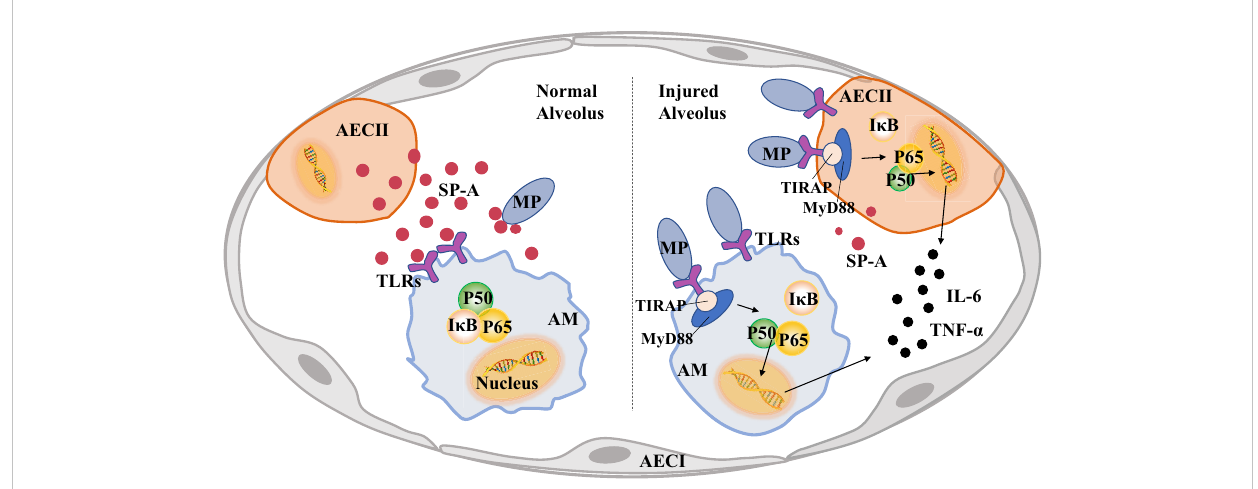
FIGURE 4 Pulmonary surfactant protein A (SP-A) links alveolar macrophages (AMs) and alveolar epithelial cells (AECs) to reduce lung injury caused by Mycoplasma pneumoniae (MP). A large amount of MP will activate TLRs-MyD88-NF- k B of AECs signaling pathway, increase the secretion of in fl ammatory factors and reduce the production of SP-A, MP also activates the pro-in fl ammatory phenotype of AMs and causes lung